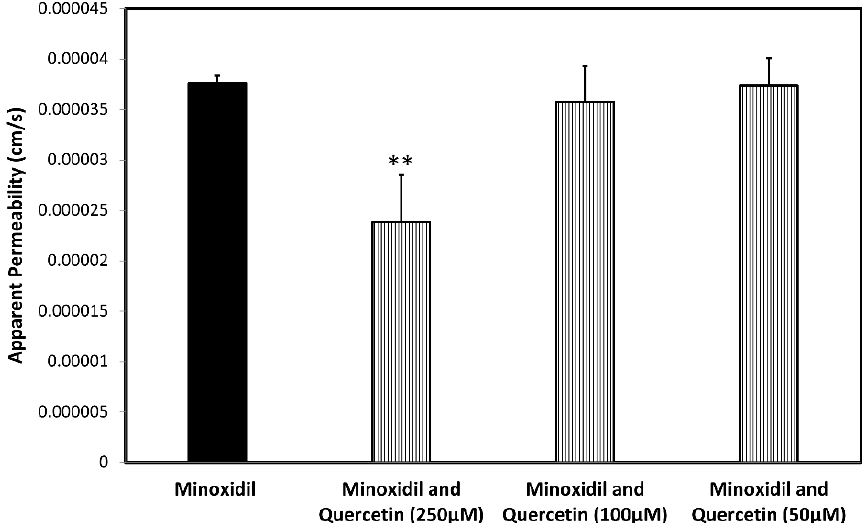
Figure 5. The permeability values of minoxidil alone and minoxidil with quercetin in different concentration across Caco-2 cell monolayers. Mean ± SD; n = 4, ** p -value < 0.01.